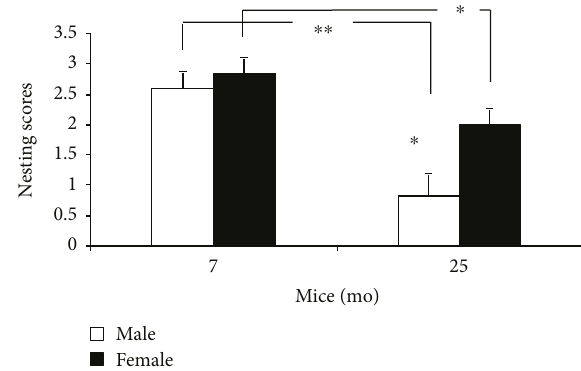
Figure 1: Nesting scores in 7- and 25-month-old C57BL/6 male and female mice (mean ± SEM). ∗ P < 0 05 ; ∗∗ P < 0 01 .